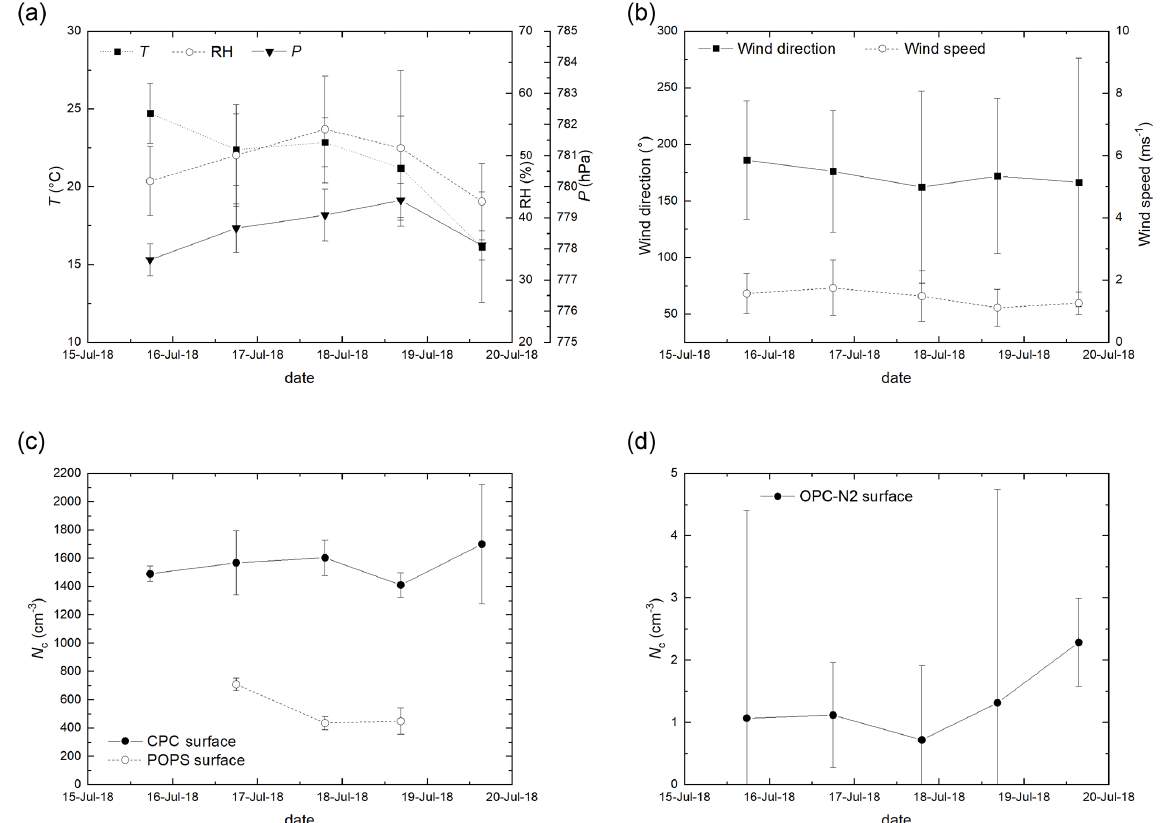
Figure 3. Overview of data collected with the FMI surface module placed on car roof about 2.75ma.g.l.: mean values with standard deviations as error-bars: (a) temperature, relative humidity, and pressure, (b) wind direction and speed by Trisonica mini weather station, (c) total aerosol number concentration by CPC and POPS (0.13–3µm, placed about 1.8ma.g.l.), and (d) aerosol number concentration by OPC-N2